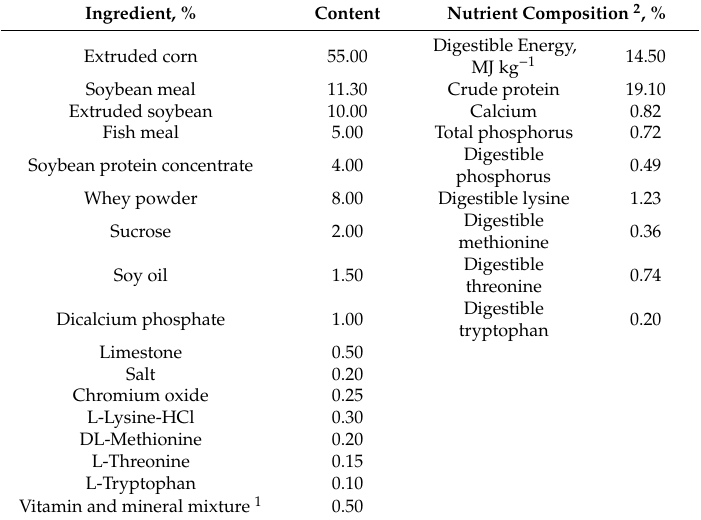
Table 1. Ingredients and chemical composition of experimental diets (as-fed basis). Ingredient,